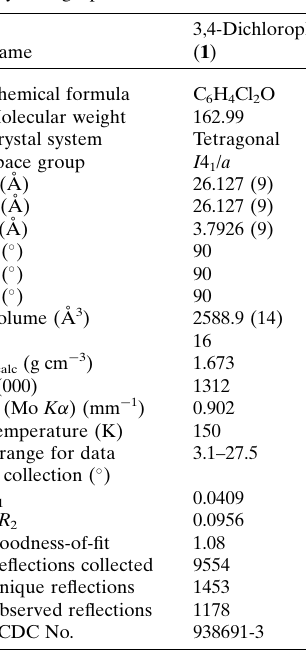
Table 1 Crystallographic